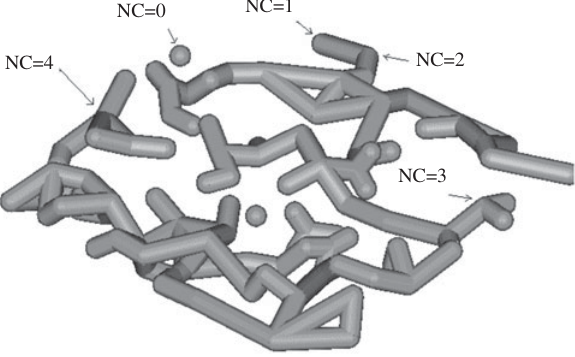
Figure 1. Structure showing nodes with different coordination numbers